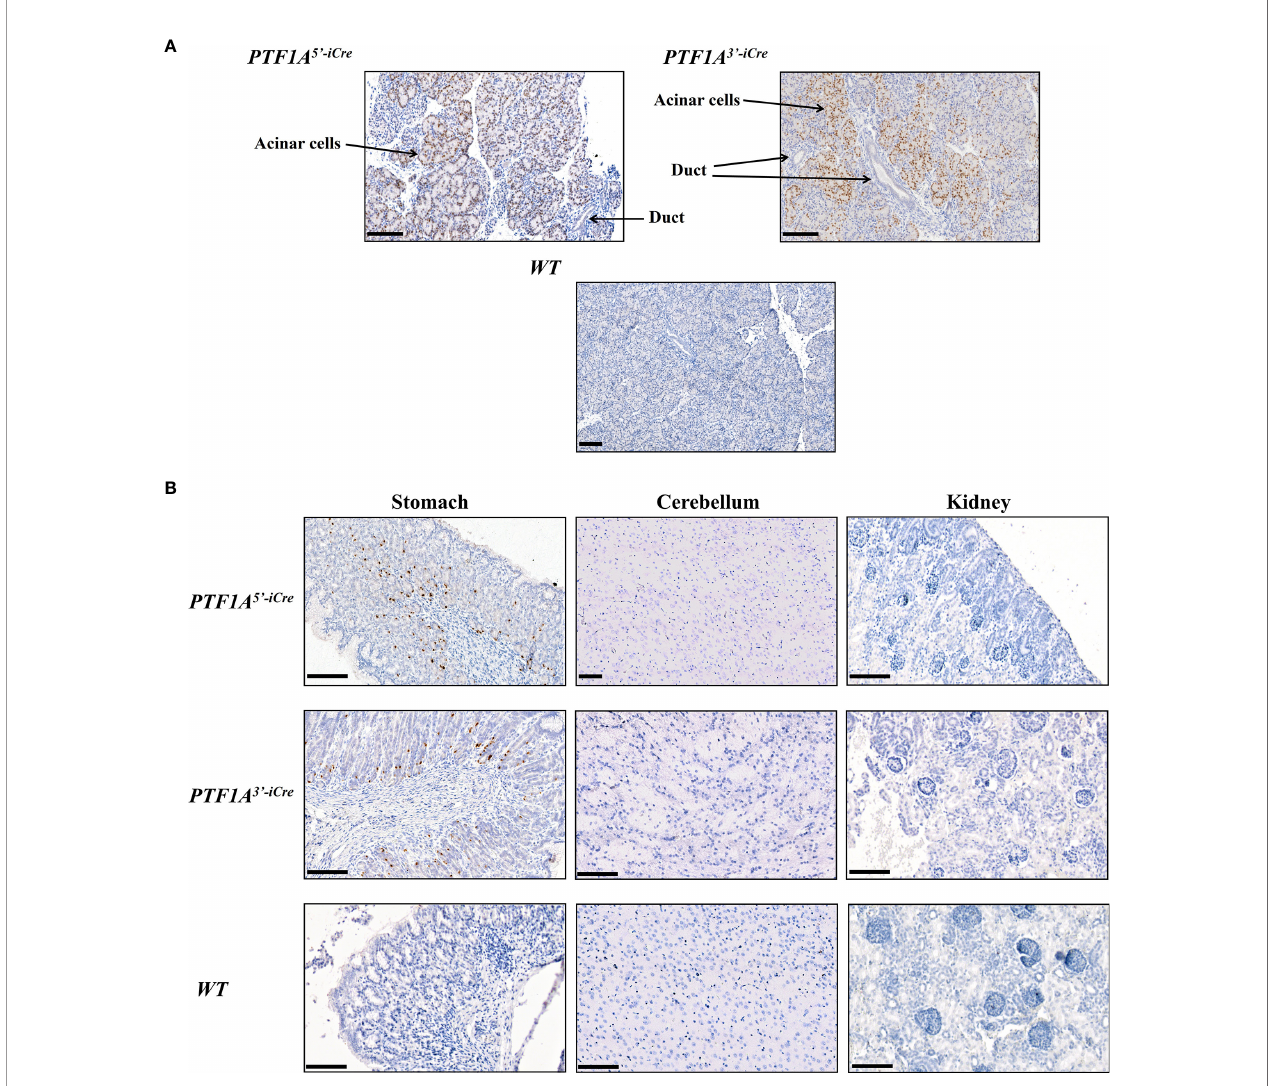
FIGURE 2 | Cre protein expression in PTF1A-iCre animals. (A) IHC stained pancreata from 1-day old PTF1A 5 ’ iCre and PTF1A 3 ’ iCre piglets show iCre protein expression in pancreatic acinar cells, but not in duct cells. (B) IHC staining of stomach, cerebellum and kidney reveals iCre protein expression in single cells of the stomach, but no expression in brain and kidney. Scale bar represents 100